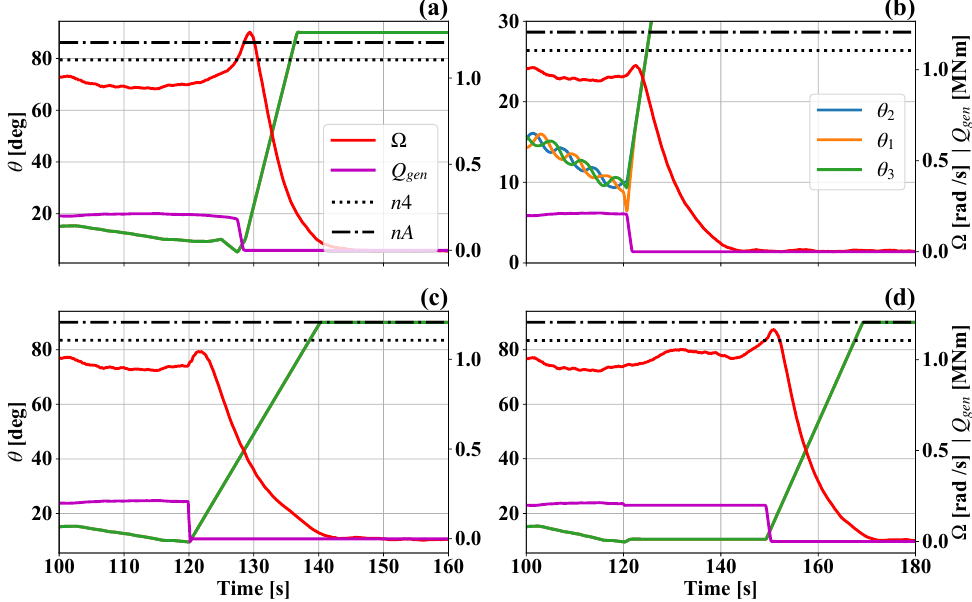
Figure 6. Events triggered by the controller: ( a ) Collective pitch-to-fine; ( b ) Individual pitch-to-fine; ( c ) Grid loss; ( d ) Speed transducer fault. In all cases, the event is captured by the supervisory controller and an appropriate stop maneuver is